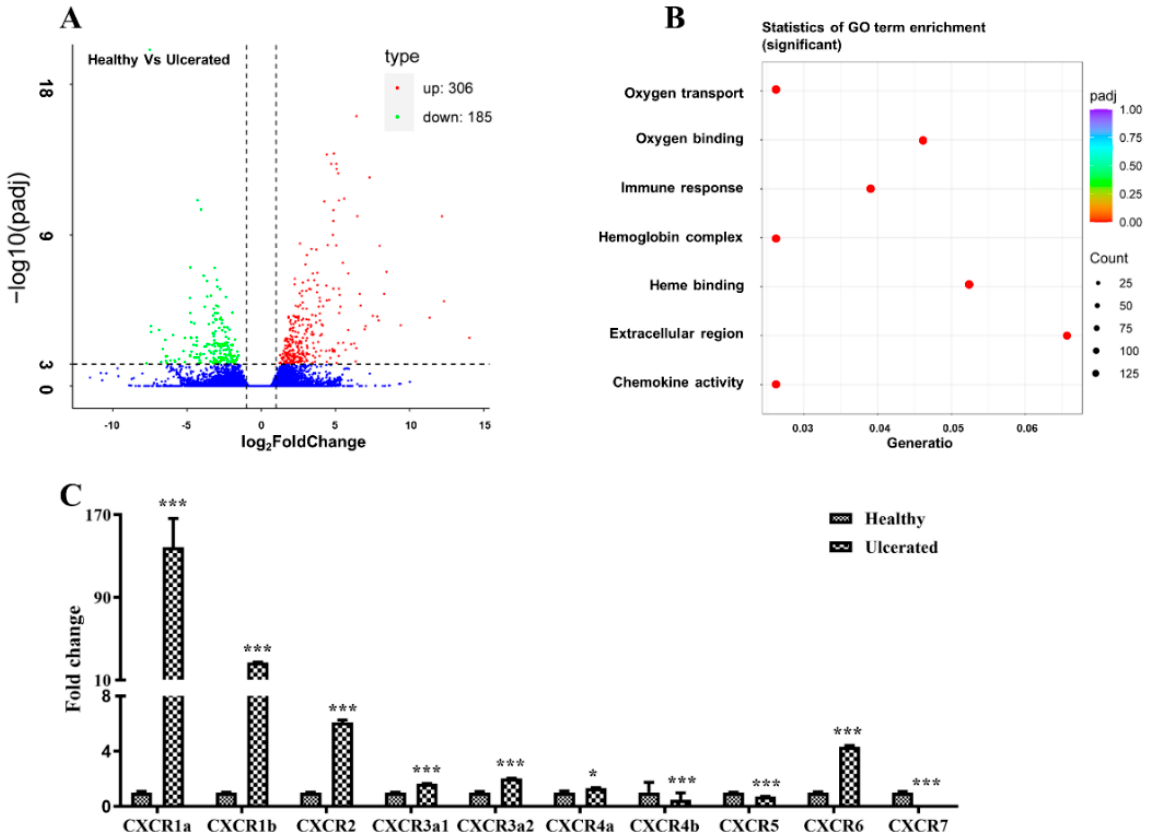
Figure 1. DEGs in healthy and ulcerated four-eyed sleeper and qPCR validation. ( A ) Volcano plot of the DEGs. ( B ) The Go term enrichment of DEGs. ( C ) qPCR analysis of CXCR members in the spleen of healthy and ulcerated. The ordinate represents the relative fold change, the expression level of CXCR in healthy fish was normalized as one (* p < 0.05; *** p < 0.001).